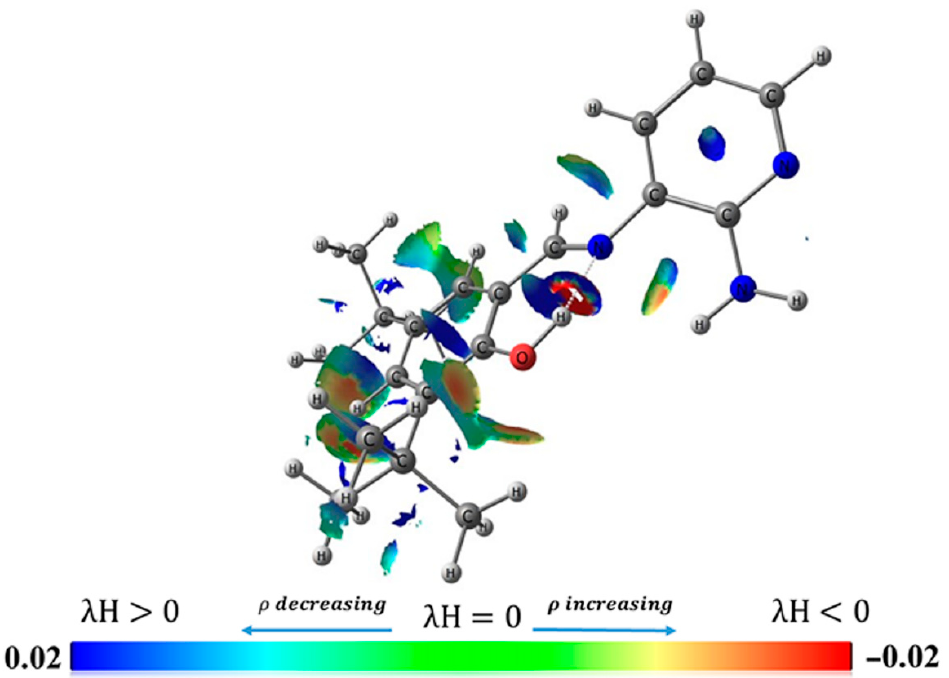
Figure 4. Noncovalent interaction (NCI) analysis of L1 . Bottom: the NCI plot gradient isosurface (0.6 a.u.) for five local and global minima structures (kcal / mol − 1 ). The NCI color scale is − 0.02 < λ H > 0.02 a.u. These calculations were performed at the B3LYP / 6-31G** level.